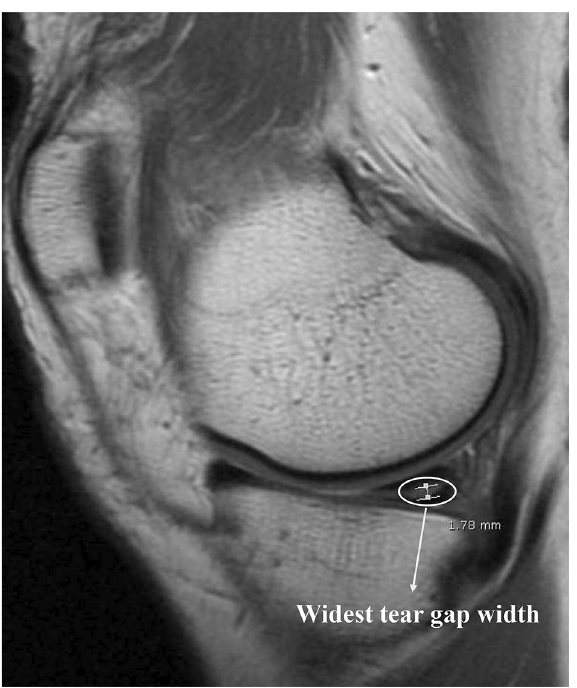
Figure 2. Widest tear gap width measured on the sagittal view of the MRI. Measurements were digitally analyzed via an image analyzing program (Marosis M-view 5.4, Marotech, Seoul,